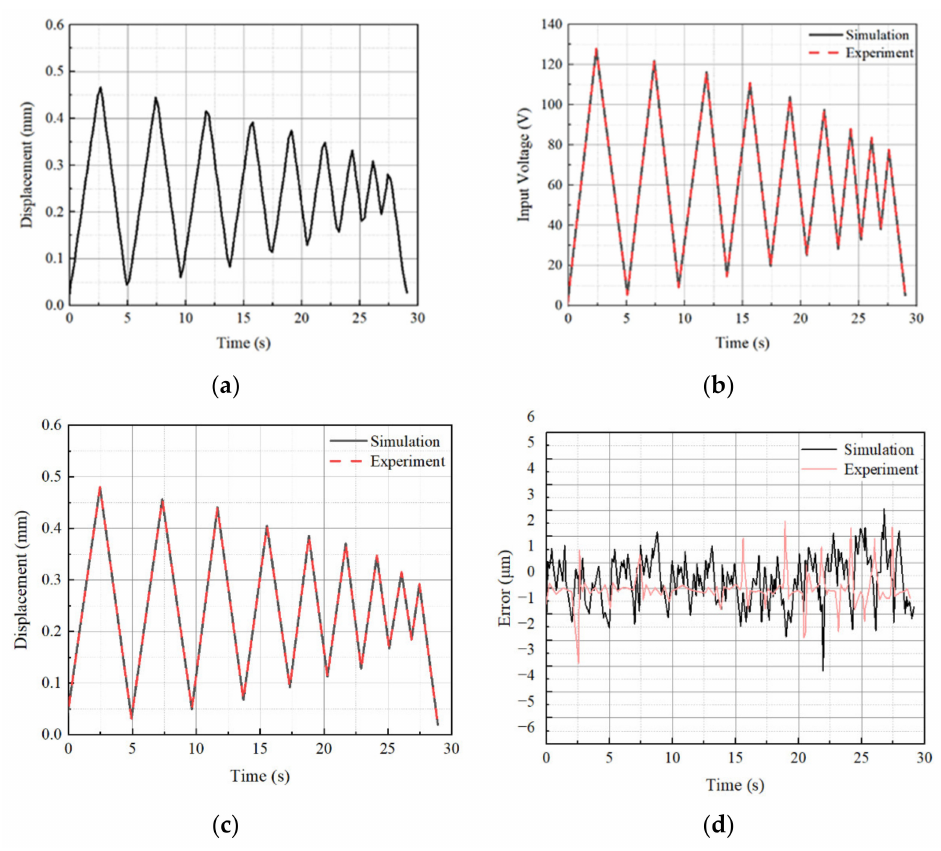
Figure 13. Tracking control results of the spool displacement with the triangular trajectory at 100 ◦ C;